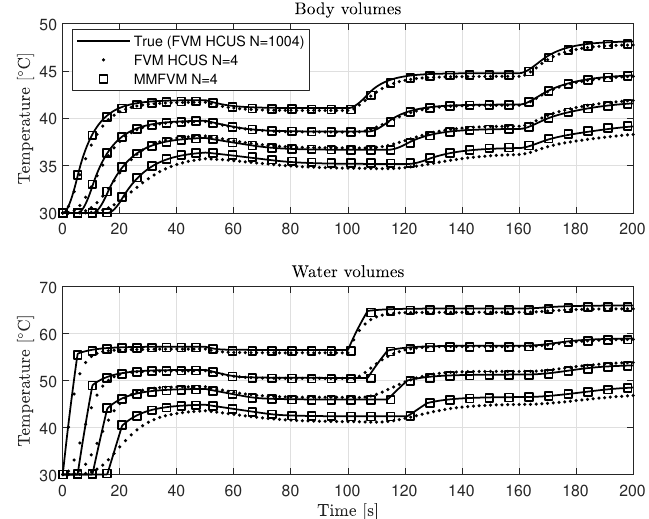
Figure 5. Time evolution of the body and water temperatures T b , T w at x = [ 0.125, 0.375, 0.625, 0.875 ] (from top to bottom ). The fine FVM solution was spatially averaged to the cell size of the latter two solutions.